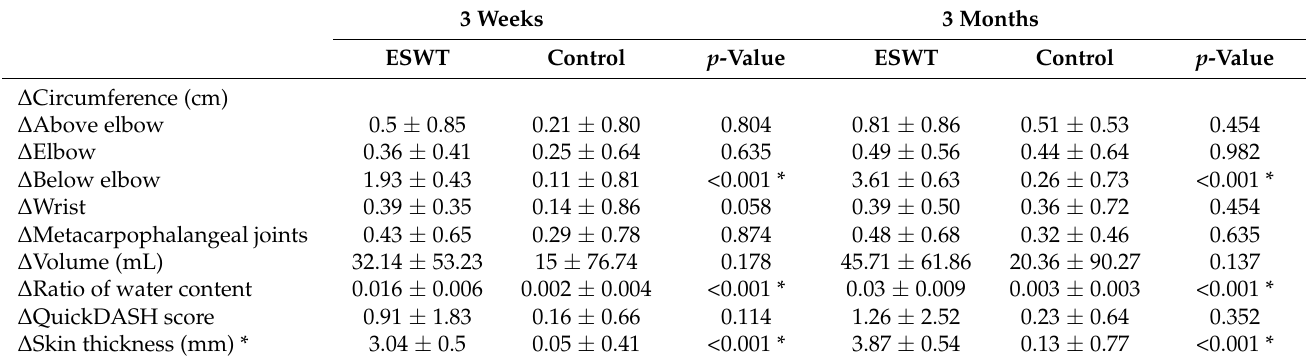
Table 3. Comparison of changes between two groups at 3 weeks and 3 months post-treatment. 3